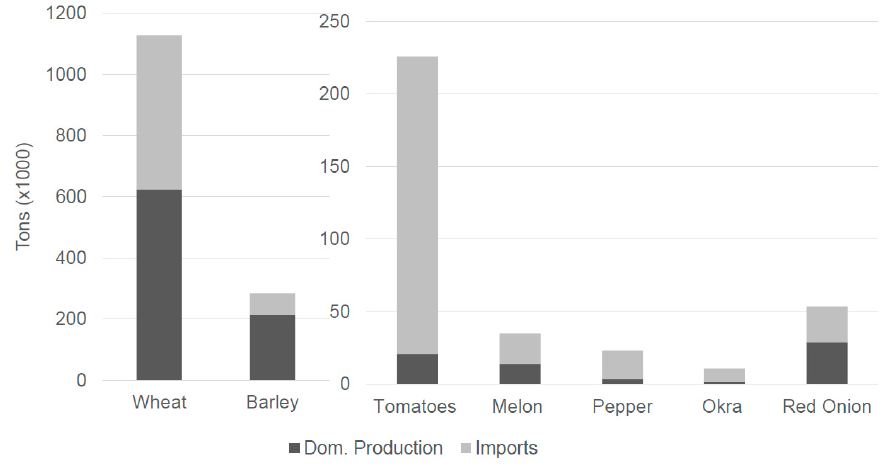
Figure 2. Kurdistan Regional Government (KRG) domestic production and imports for 2010. Source: Kurdistan Region Statistics Office (KRSO) [39,40].